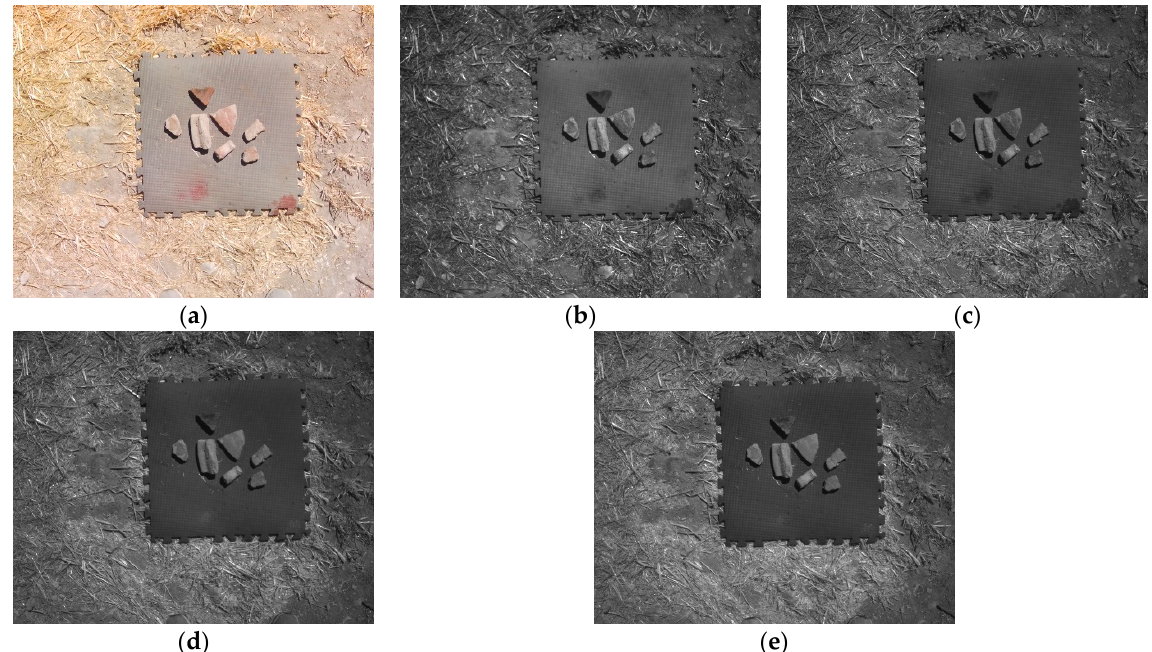
Figure 9. Example of photo taken from the UAV multispectral sensor: ( a ) RGB image; ( b ) blue band; ( c ) green band; ( d ) red band; ( e ) NIR band.